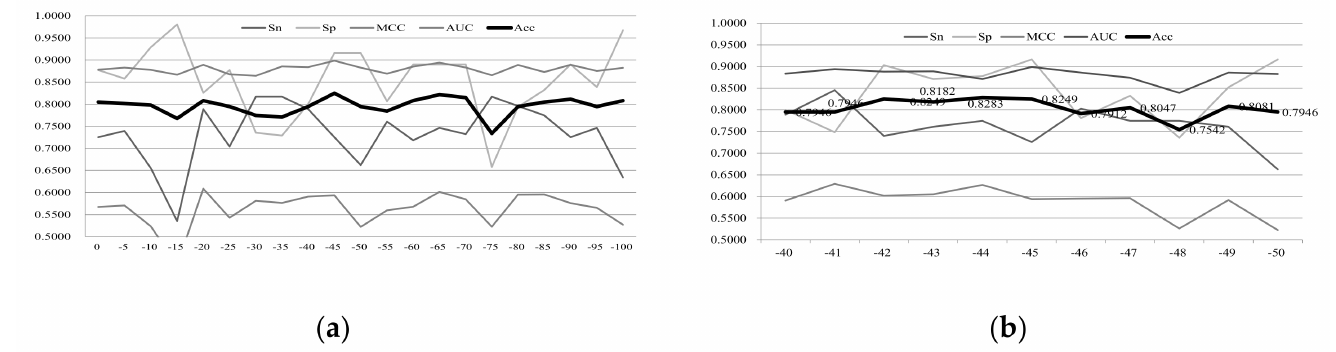
Figure 1. Performance evaluation of the models using the 2-mer SeqPose features after filtering out some redundant features. The vertical axis gives the values of the five performance metrics, including Sn, Sp, MCC, AUC, and Acc. The horizontal axis is the number of features removed from the 2-mer SeqPose features, i.e., “ − 5” means that the five features with the largest p -values are removed from the list of all 2-mer SeqPose features. The feature removal is carried out in two steps, i.e., ( a ) five features are removed in each iteration; and then ( b ) one feature is removed in each iteration from the list of features “ − 45”.